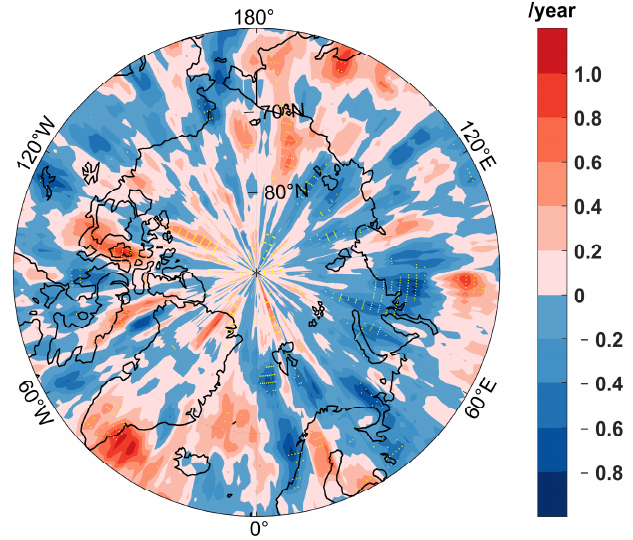
Figure 3. Trends of autumn cyclone frequency in the period 2001 to 2017. The yellow dots denote the 95% con fi dence level.